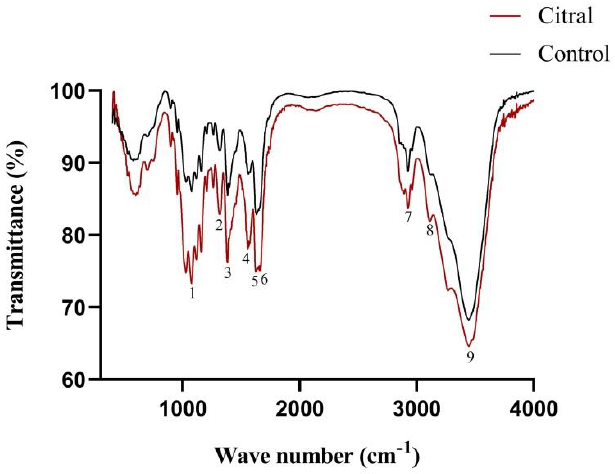
Figure 4. FTIR spectra of α -chitin from R. flaviceps in the control and citral-treated groups.